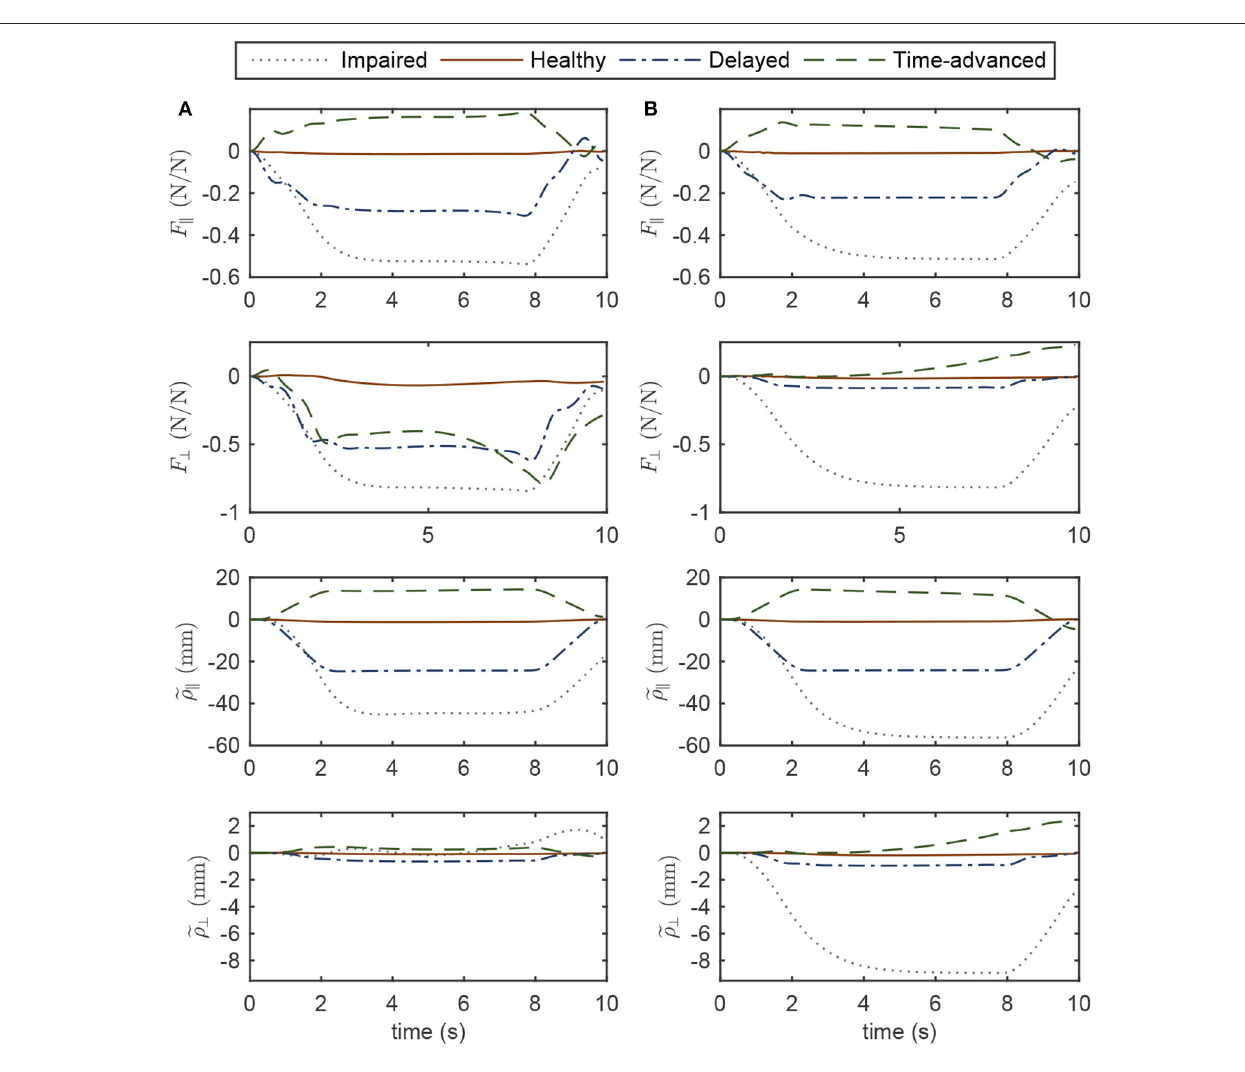
FIGURE 6 | Operational space normalized interaction force and position error in four modes of simulations while controlling the robot with (A) OIC, (B) SOIC. Subscripts and indicate the tangent and normal directions, k ⊥